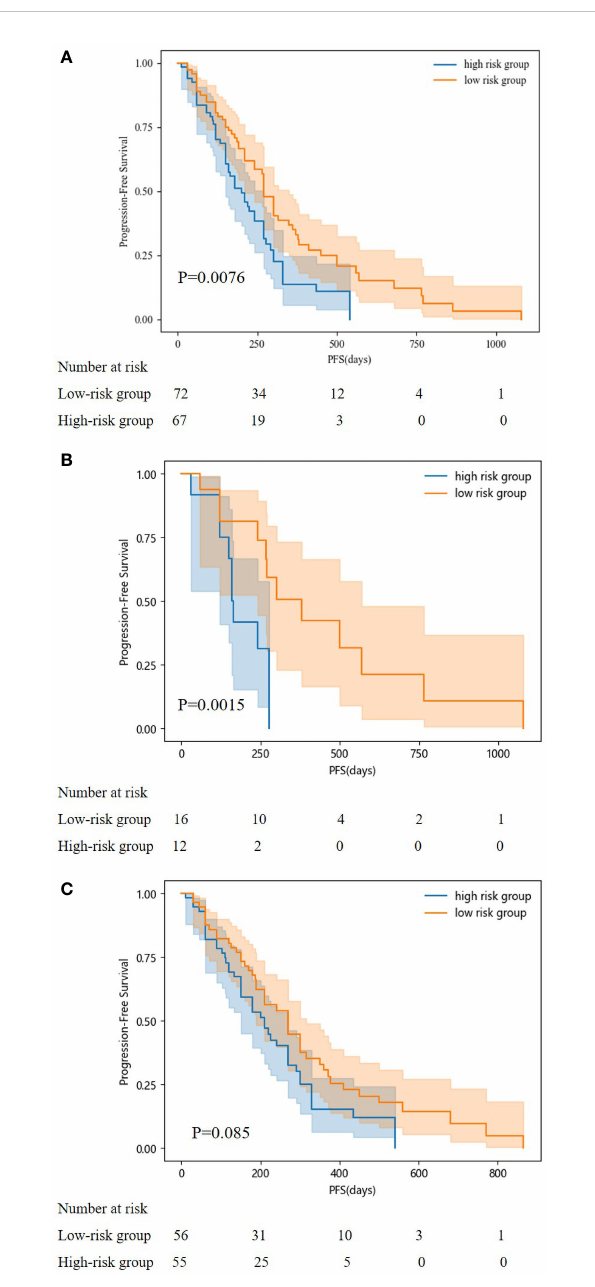
FIGURE 5 Kaplan-Meier curves for predicting PFS of patients in low and high- risk groups. ( A : in the whole set; B : in testing set; C : in training